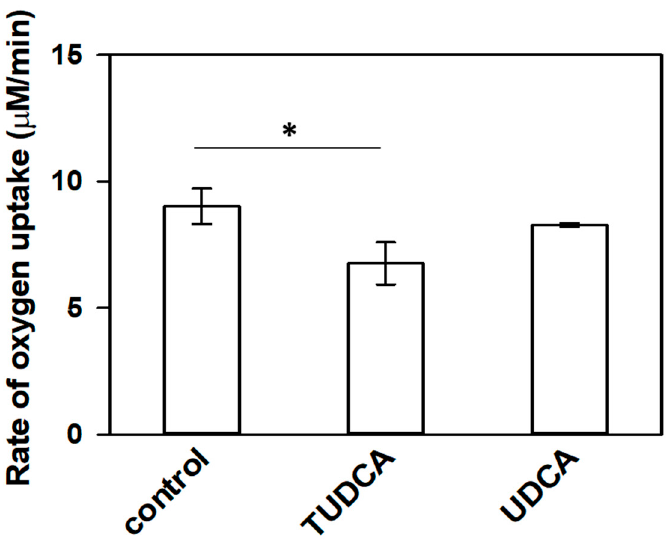
Figure 3. Oxygen consumption in liposomal samples composed of a mixture of synthetic lipids, naturally present in the photoreceptor membranes, exposed to free radical flux generated in Fenton reaction. Bars represent initial rates of oxygen uptake ( µ M/min). Decrease in oxygen consumption rate observed in the presence of TUDCA in liposomes statistically significant in comparison to control sample—liposomes not containing bile acid (* p < 0.05).